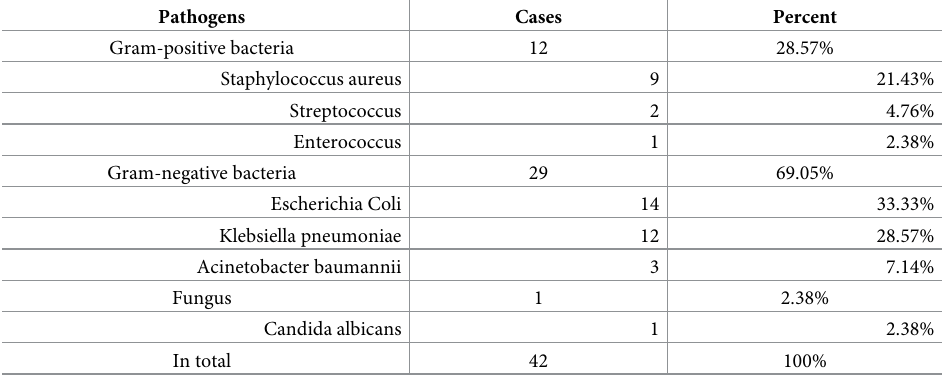
Table 4. The pathogen distributions of postoperative pulmonary infection in patients with hip fracture (n =